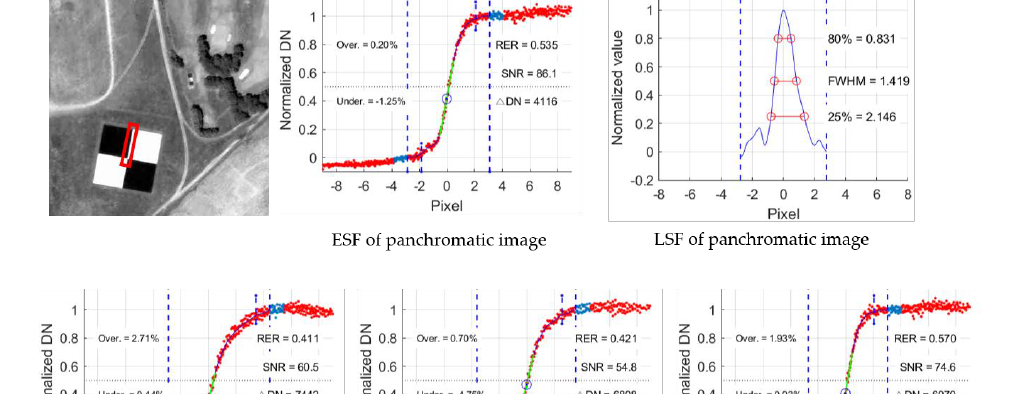
Figure 9. Histogram plot of local injection gains according to blue band of the Salon region of France: ( a ) result by Equation (9) [5]; ( b ) result by the proposed algorithm (Equation (14)). Moreover, the spatial quality of images pansharpened using an ESF and LSF is further analyzed. Figures 10 and 11 show the ESF and LSF along and across the panchromatic image in the blue band according to each algorithm in the Salon and Baotou regions, respectively. As shown in Figures 10 and 11, the ESF curves of the pansharpened image generated by the GFNDVI present a pattern similar